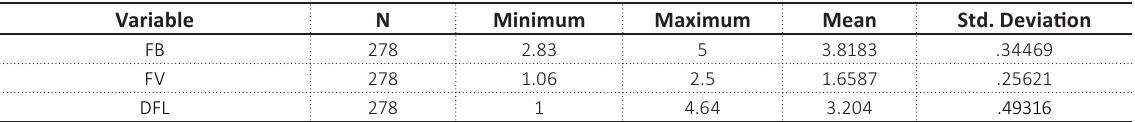
Table 2. Descriptive statistics